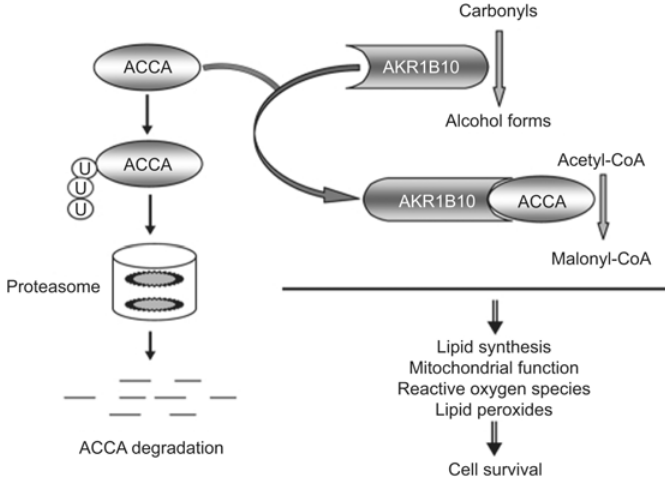
Figure 4 Hypothetical model of AKR1B10 in regulating cell growth and